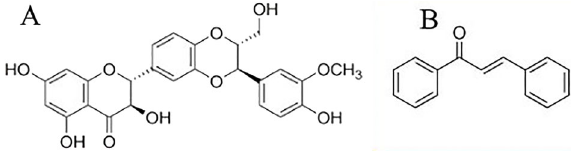
Figure 1. 2D structure of ( A ) silibinin and ( B ) trans-